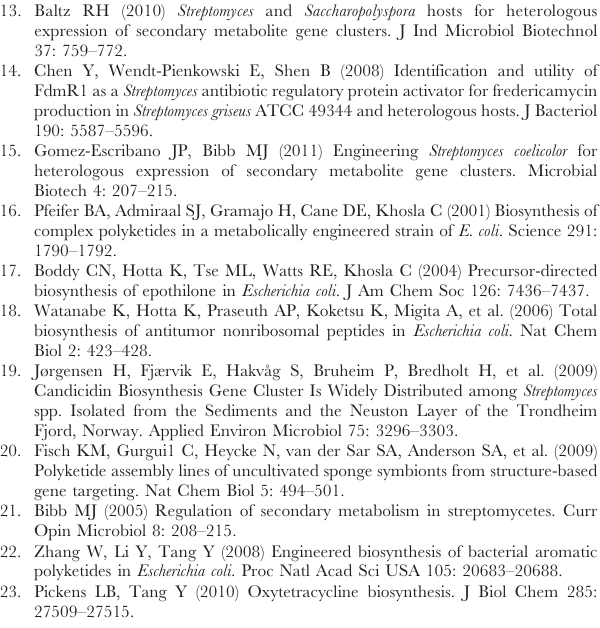
Figure S4 SDS-PAGE of the soluble fraction from oxytetracycline producing strains. Lane 1 is protein ladder, lane 2 is the soluble fraction from uninduced BAP1, lane 3 is the